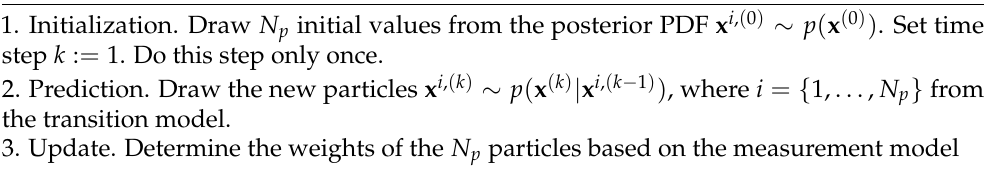
Algorithm 1 Bootstrap Particle Filter